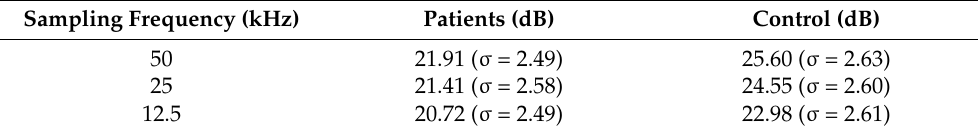
Table 4. HNR as a function of the Sampling Frequency for the control and patient groups.